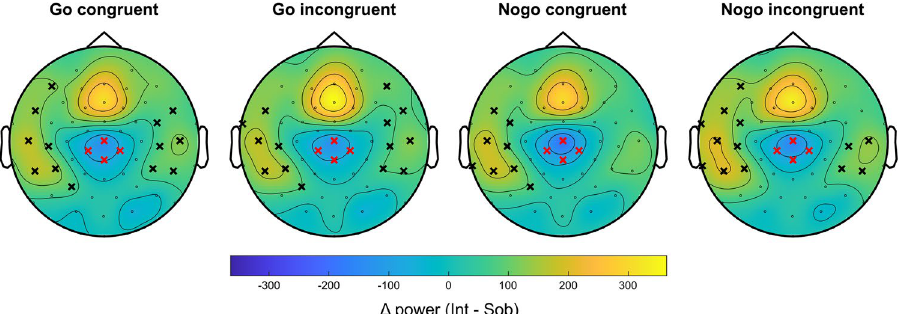
Figure 2. Depiction of the intoxication effect (intoxicated minus sober) on theta band activity at the electrode level. In all four experimental conditions, the intoxicated participants showed significantly higher theta power at lateral electrodes (marked with a black “x”) and significantly lower theta power at parieto-central electrodes (marked with a red